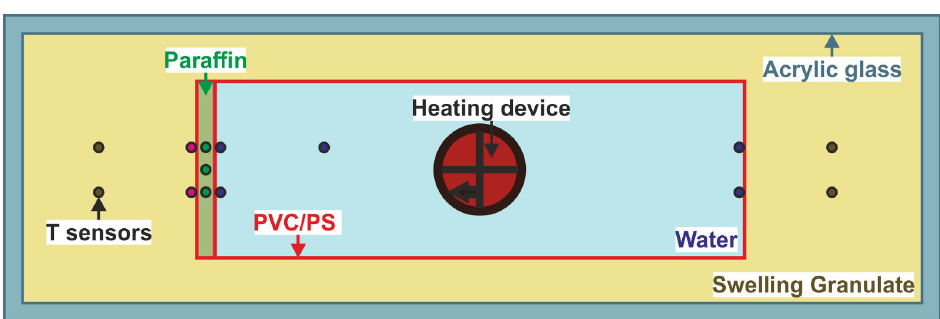
Fig 1. Schematic top view of the thermal performance experimental setup showing the positions of temperature sensors and materials used. PVC: polyvinylchloride foil, PS: polystyrene glass plates.